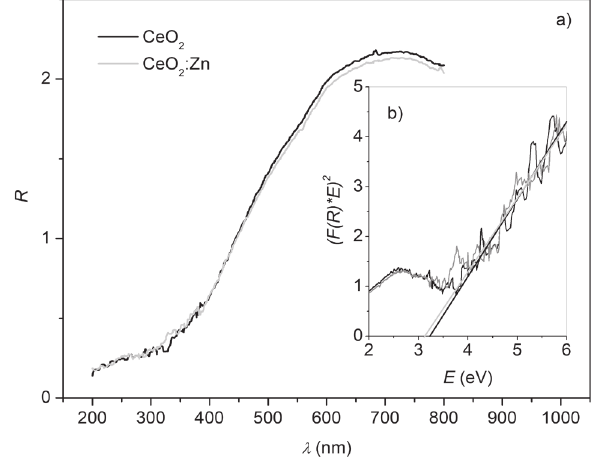
Fig. 3 – Diffraction patterns of the pure and doped samples Fig. 4 – UV-Vis diffuse reflectance spectra (a) and Tauc’s plots (b) of the pure and doped